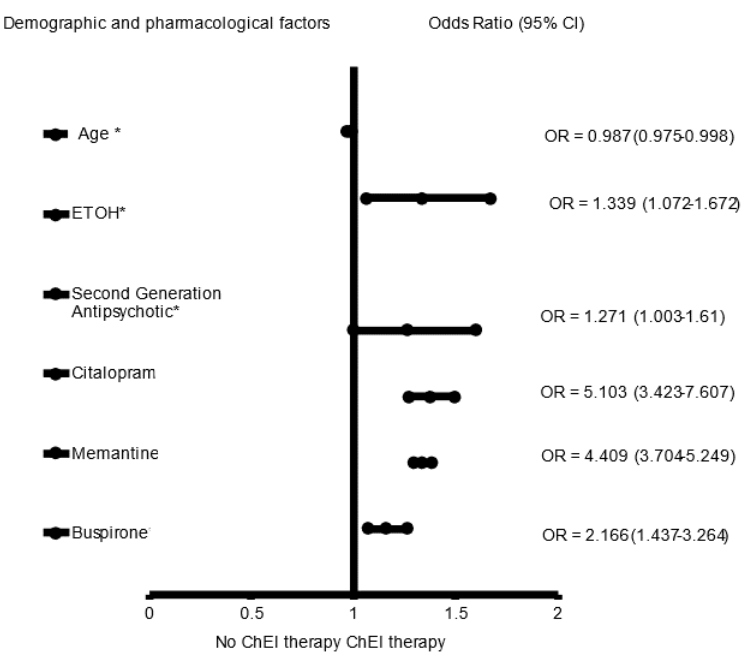
Figure 2. ROC curve associated with prediction of receiving cholinesterase inhibitor (ChEI) for late onset Alzheimer’s patients independent of gender. Higher area under the curve (AUC) values in ROC analysis indicate better discrimination of the score for the measured outcome. Classification table (overall correctly classified percentage = 67.2%) and area under the ROC curve (AUC = 0.697, 0.685 – 0.708) were applied to check model fitness.